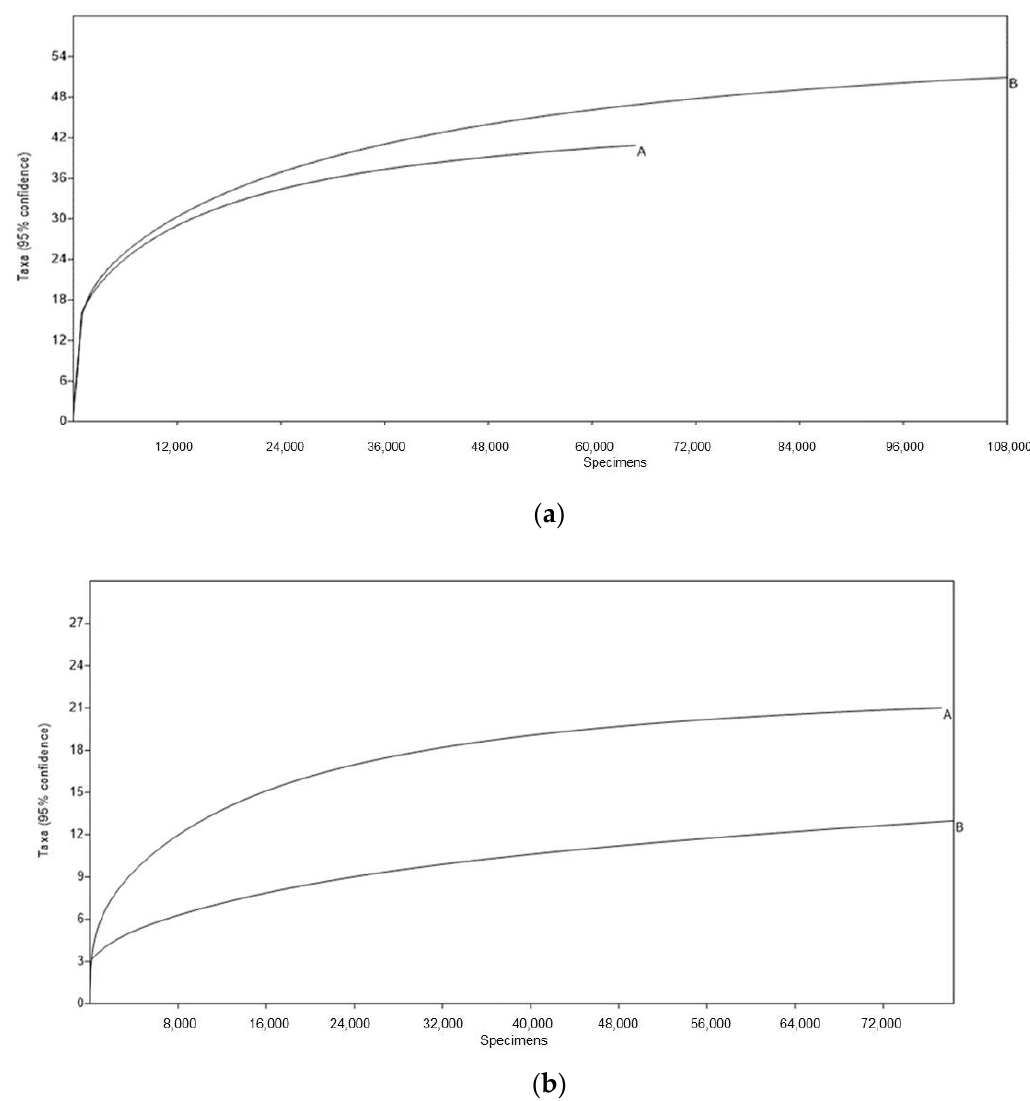
Figure 7. ( a ) Rarefaction curves for the partial sequences for the gene that encodes 16S rDNA of bacteria before incubation (A) and after incubation (B). ( b ) Rarefaction curves for the partial sequences for the ITS 2 region of fungal rRNA before (A) and after (B) incubation.